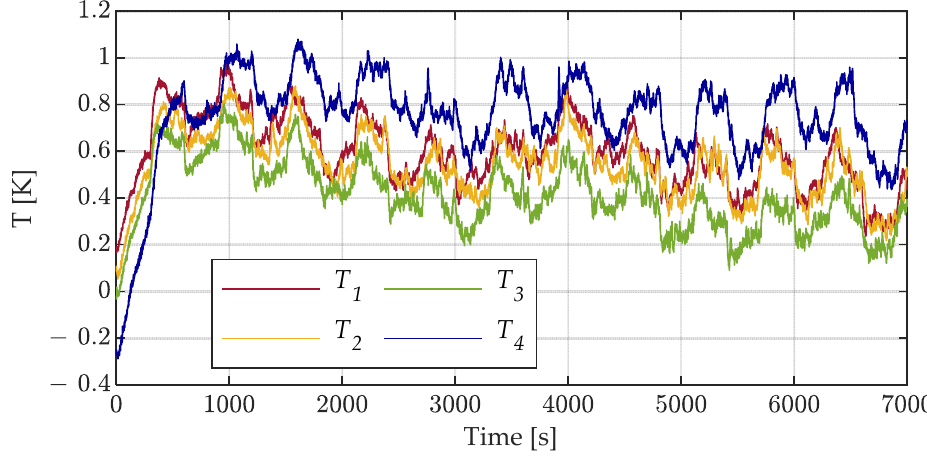
Figure 14. Error test single cell 15 A.